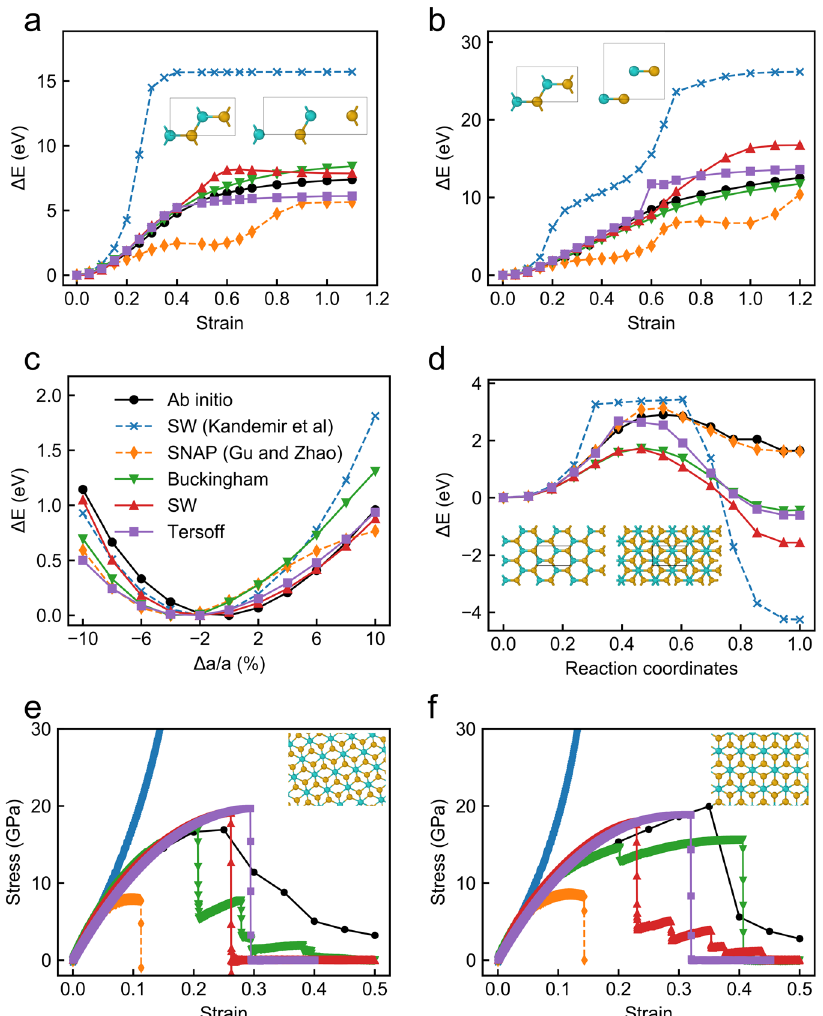
Fig. 3 Prediction results of the parameterized interatomic potentials in comparison to ab initio results, as well as the existing SW 16 and SNAP potentials 30 . a , b Bond dissociation energy landscape along the armchair ( a ) and zigzag ( b ) directions. Two snapshots along the landscape are shown and correspond to strain of 0 and 0.6, respectively. c Equation of state. d 2H-1T phase transition energy landscape. The two snapshots from left to right correspond to reaction coordinates of 0 and 1, respectively (see Supplementary Video 1 for the movie of this simulation). e , f Uniaxial stress – strain curve at 1 K in comparison to ab initio curves under soft mode (see Supplementary Note 1) along the armchair ( e ) and zigzag ( f ) directions. The snapshots in e and f show the formation of the 1T phase during uniaxial tension for the Buckingham potential, which is also predicted by the SW potential during uniaxial tension along the zigzag direction. Legends of a , b , d – f are identical to that in c , and are omitted for clarity. In the atom snapshots, Mo atoms are colored cyan, and Se atoms are colored in the M -dimensional design space enables a quantitative assessment of the relations between the M properties through statistical analysis. From the N × M matrix, we construct an M × M correlation matrix where each element R ij is the Pearson correlation coef fi cient between property i and property j . A correspond to individuals with percentage errors <100% for all properties. Such setting aims at exploring regions in the criterion space where promising candidates are selected. R ij ranges from − 1 to 1, denoting strongly negative and positive correlations, respectively. In the context of our problem, a positive R ij between property i and j indicates simultaneous increase or decrease of their prediction errors, and hence noncon fl icting relations between the two properties. In comparison, a negative R ij suggests a con fl icting relationship between property i and j : the errors for property i cannot be minimized without compromising the accuracy of property j .